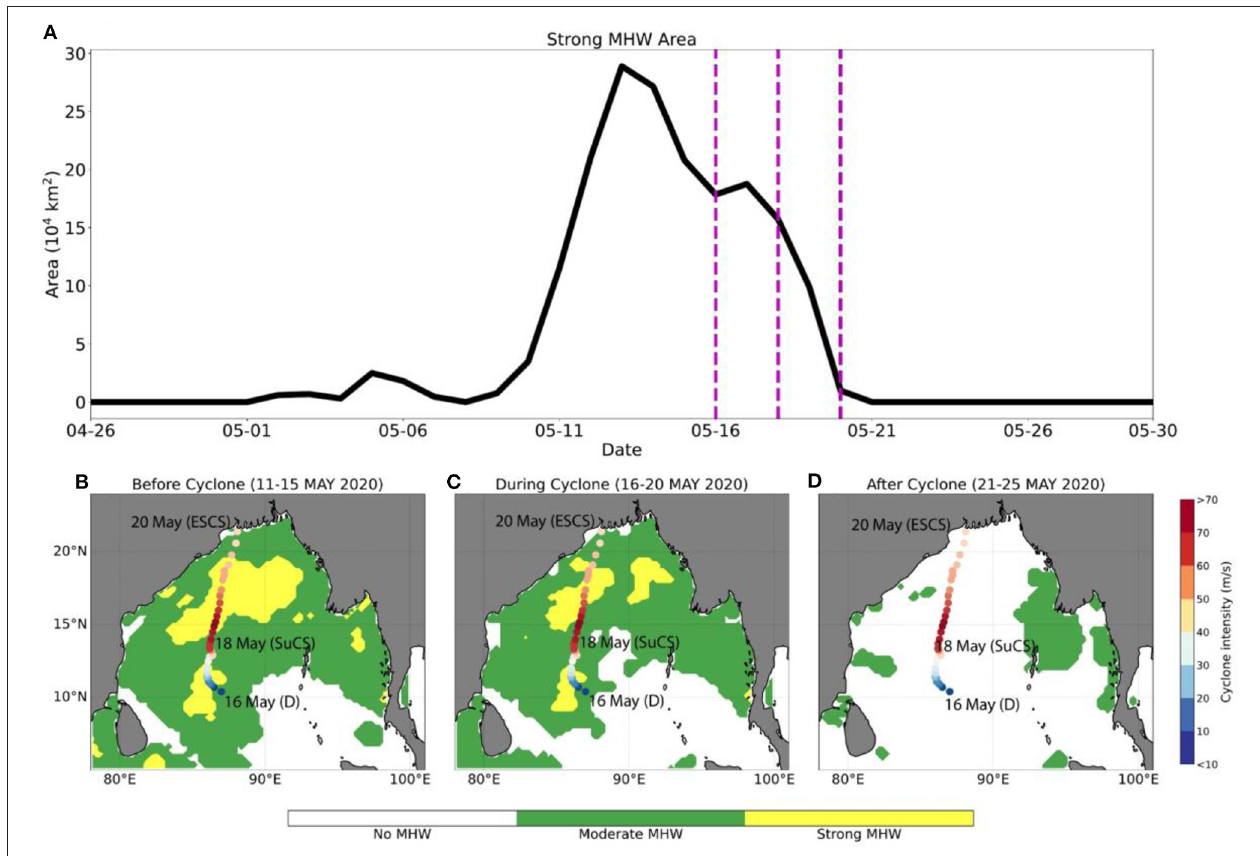
FIGURE 3 | (A) Ocean surface area of the Bay of Bengal covered by strong marine heatwave conditions with vertical magenta lines representing cyclogenesis (left), cyclone intensification (middle) and landfall (right) for tropical cyclone Amphan, (B–D) categories of marine heatwave over the Bay of Bengal before the tropical cyclone Amphan (averaged over 11–15 May 2020), during the cyclone (averaged over 16–20 May 2020) and after the cyclone (averaged over 21–25 May 2020) overlaid by the track of the cyclone which is shaded by the mean daily intensity of the cyclone (m s − 1 ) with the date of cyclogenesis (CS, 16-May-2020), date of super cyclonic storm (SuCS, 18-May-2020) and landfall as extremely severe cyclonic storm (ESCS